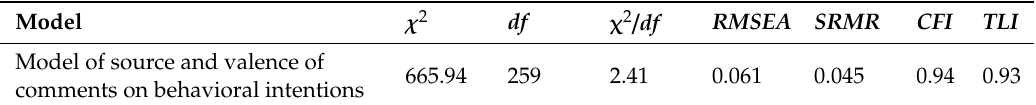
Table 2. Summary of Model Fit.